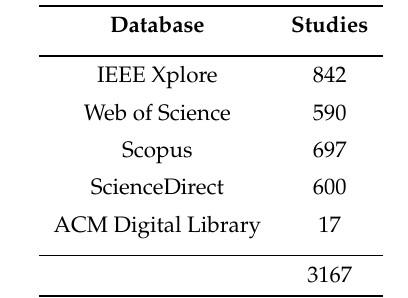
Table 7. Studies obtained by the chosen database.